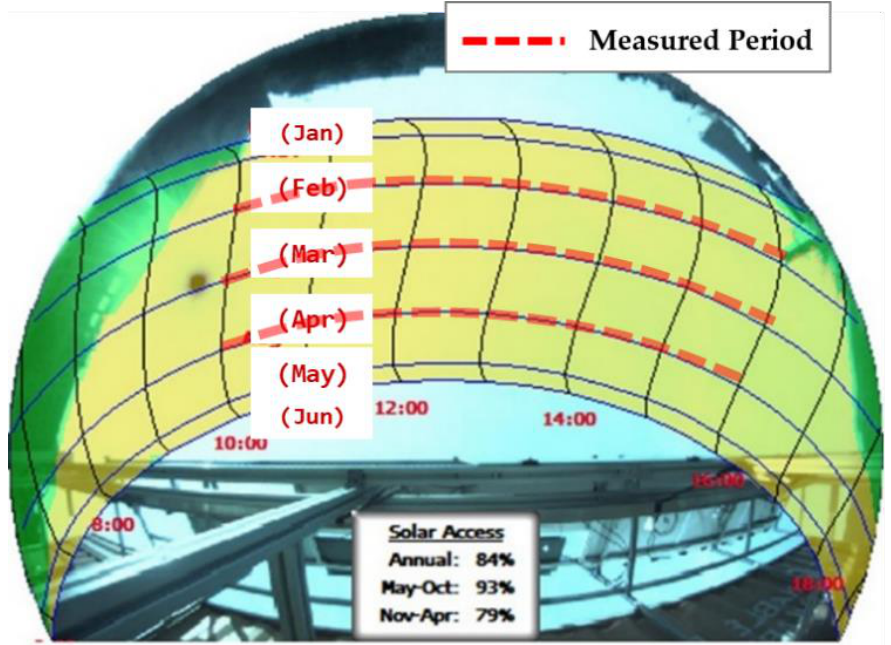
Figure 5. Sun-path diagram used to identify specific shade-causing obstructions by the measurement site [25].